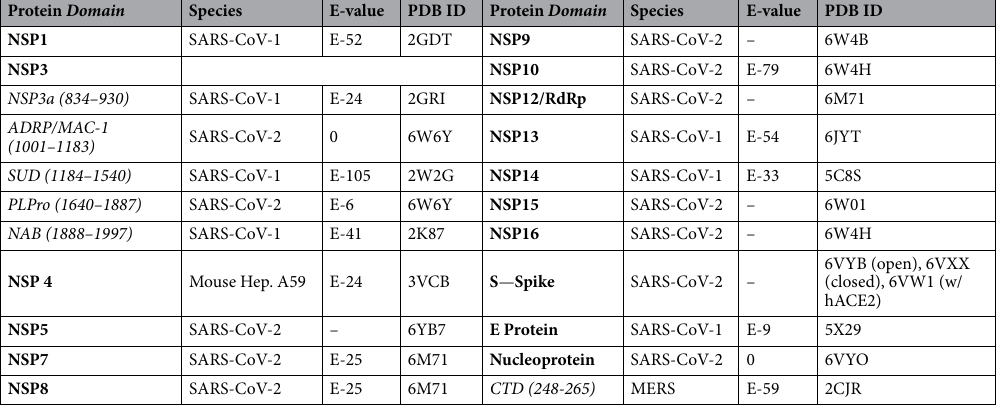
Table 1. SARS-CoV-2 proteins, domains, and